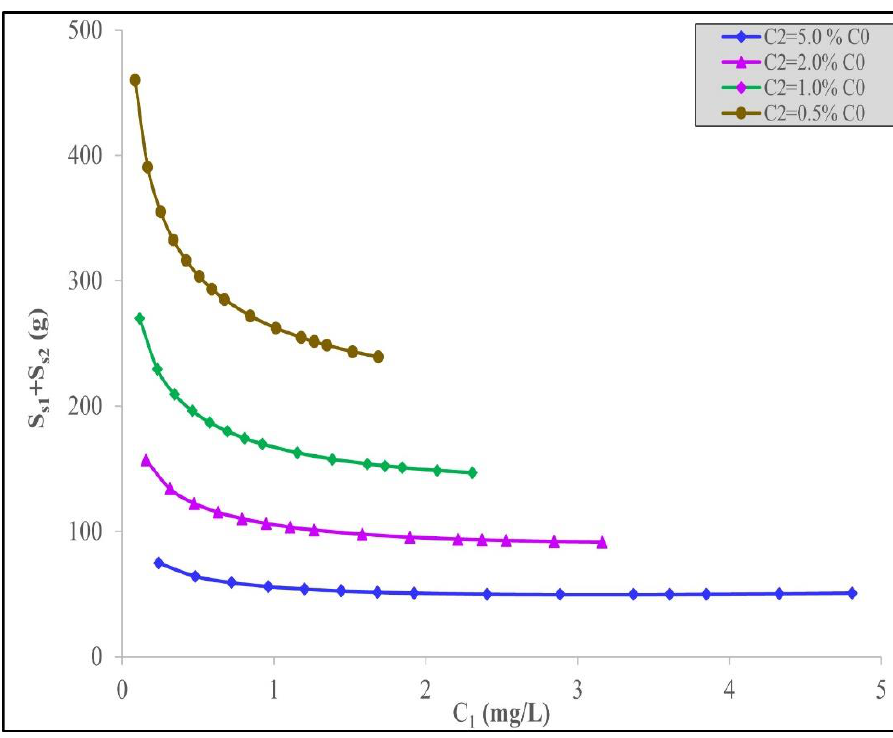
Figure 4. Minimum quantity of acid-treated date stone activated carbon, S 1 + S 2 , against the inter- stage concentrations, C 1 , to remove IBU using the Langmuir – Freundlich model for different removal concentrations, C 1 , to remove IBU using the Langmuir–Freundlich model for different removal values, values, % C 0 . % C 0